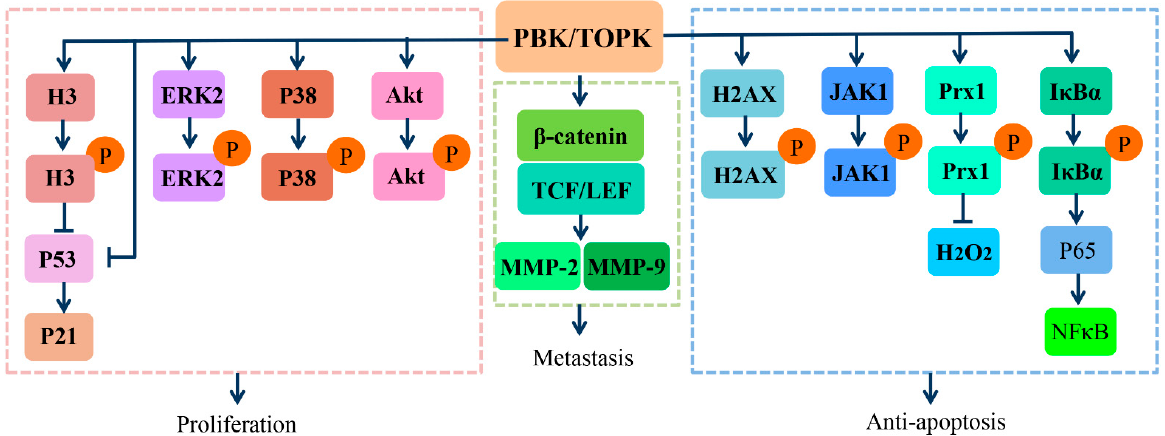
Figure 3. Signaling pathways involved in tumorigenic functions of PBK/TOPK. Abbreviations: H3, histone H3; ERK2, extracellular signal-regulated kinase 2; TCF/LEF, T-cell factor/lymphoid enhancer–binding factor; MMP-2/9, matrix metalloproteinase-2/9; JNK1, c-Jun-NH2-Kinase 1; Prx1, peroxiredoxin1; I κ B α , inhibitor- κ B α ; NF- κ B, nuclear factor kappa